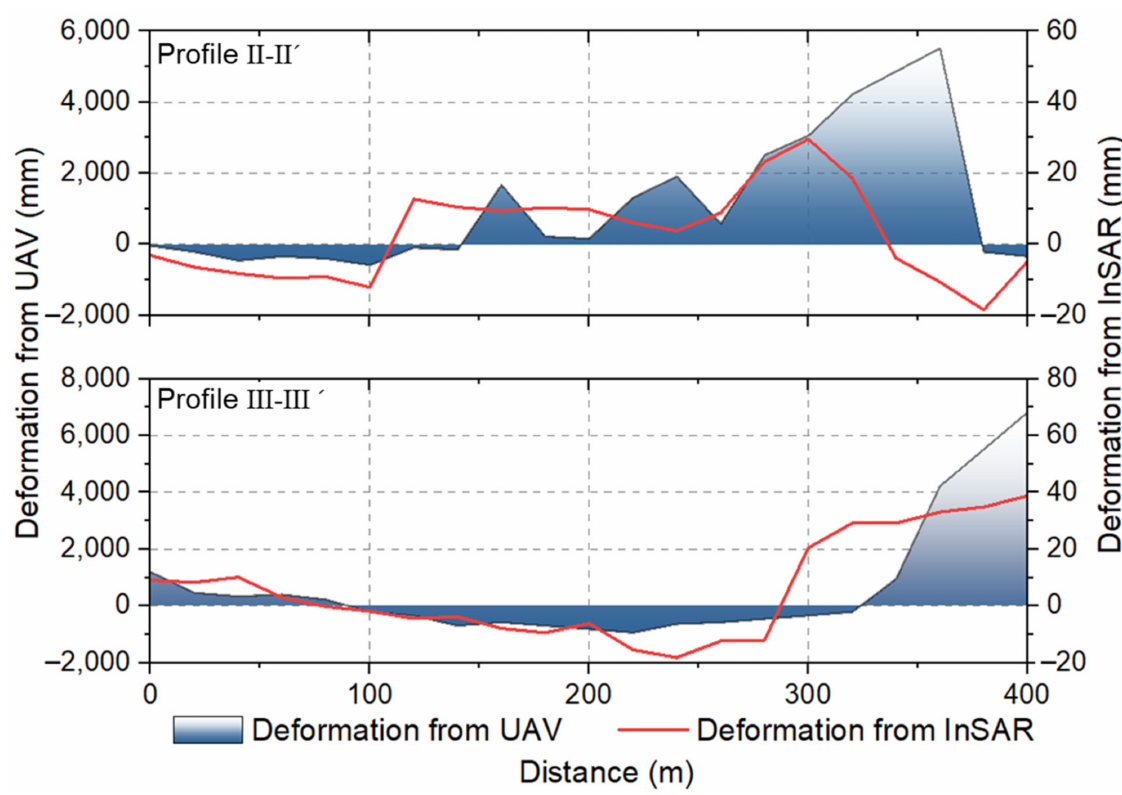
Figure 11. Comparison of InSAR interferometry and UAV photogrammetry results along the two